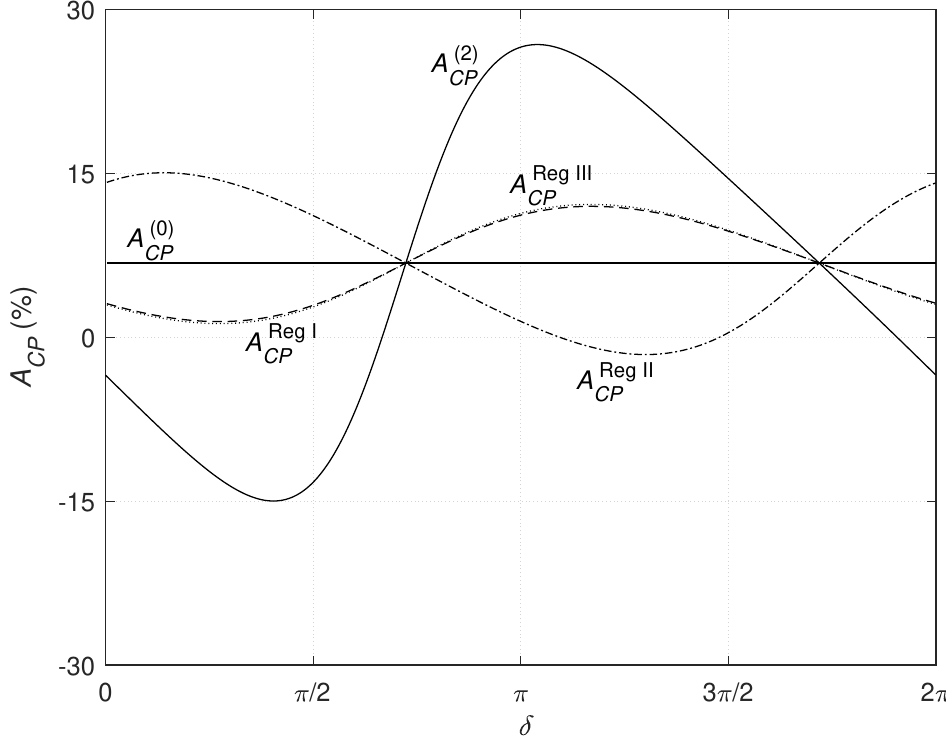
Figure 1 . The PW CP A A (2) (solid curvy line) for Λ 0 → pπ − π + π − near the resonance ∆ 0 (1232) b CP as a function of the strong phase δ . The regional CP asymmetry A (0) (solid straight line), A Reg I CP CP (dotted line), A Reg II (dash-dotted line), and A Reg III (dashed line) are also shown for comparison. CP CP The difference between A Reg I and A Reg III is very tiny. Other PW CP As A (1) and A (3) are not CP CP CP CP shown due to the reason explained in the text. The invariant mass squared s pπ is integrated from ( m ∆ − Γ ∆ ) 2 to ( m ∆ + Γ ∆ ) 2